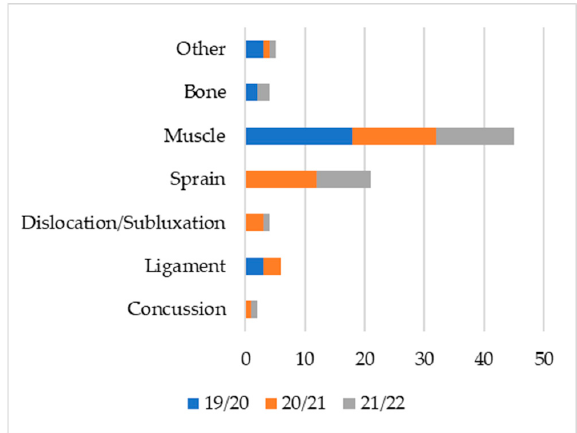
Figure 2. Injury frequency by type (n).